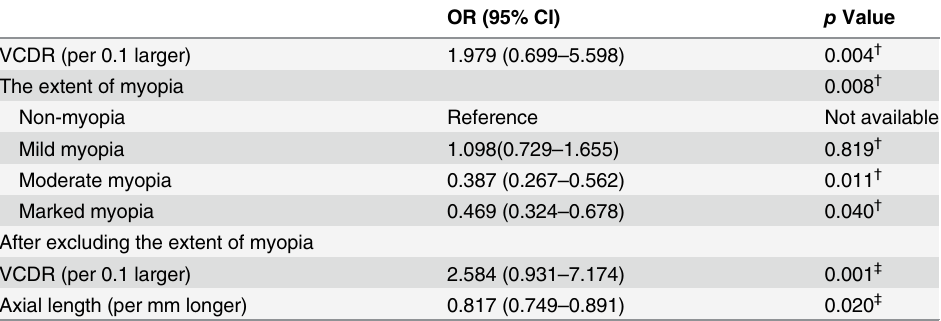
OR (95% CI) p Value